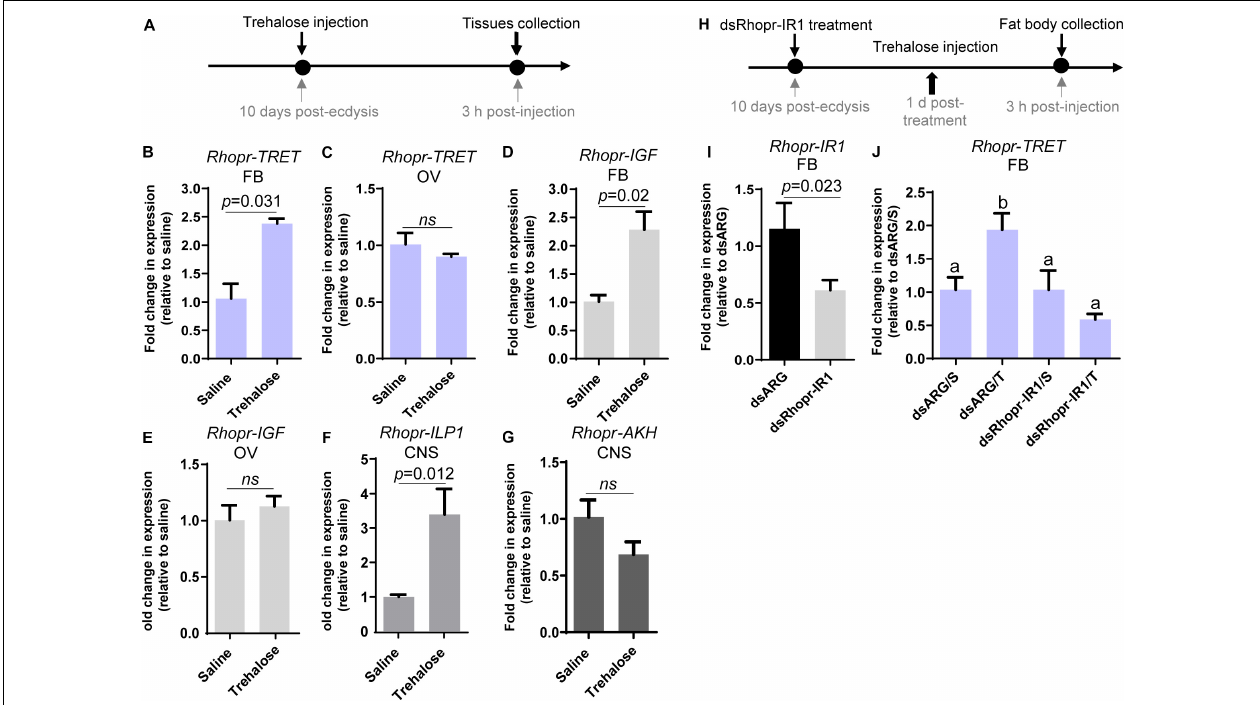
FIGURE 8 | Effects of trehalose injection on the expression of Rhopr-TRET and genes involved in insulin and AKH signaling. (A) Experimental scheme for (B–G) . Unfed adult females were injected with either trehalose or saline (control). The fat body, ovaries and CNS were dissected 3 h after trehalose injection. (B) Rhopr-TRET transcript expression in the fat body and (C) the ovaries; (D) Rhopr-IGF transcript expression in the fat body and (E) in ovaries; (F) Rhopr-ILP1 and (G) Rhopr-AKH transcript expression in CNS. The effects were measured by RT-qPCR. The y -axis represents the fold change in expression relative to control (saline injection, value ∼ 1). (H) Experimental scheme for (I,J) . Panel (I) shows the knockdown efficiency of dsRhopr-IR1 treatments. Panel (J) shows the effects of down-regulation of Rhopr-IR1 transcripts on Rhopr-TRET mRNA expression following trehalose stimulation. The y -axis represents the fold change in expression relative to dsARG injection after saline treatment (dsARG/S, value ∼ 1). In all the cases, the results are shown as the mean ± SEM ( n = 4–5, where each n represents an individual tissue from 1 insect). Statistically significant differences were determined by Student’s t -test in all graphs except for (J) in which a one-way ANOVA and Tukey’s test as post hoc test was used (different letters indicate significant difference at P < 0.05). dsARG/S: dsARG insects with saline injection; dsARG/T: dsARG insects with trehalose injection; dsRhopr-IR1/S: dsRhopr/IR1 insects with saline injection; dsRhopr-IR1/T: dsRhopr-IR1 insects with trehalose